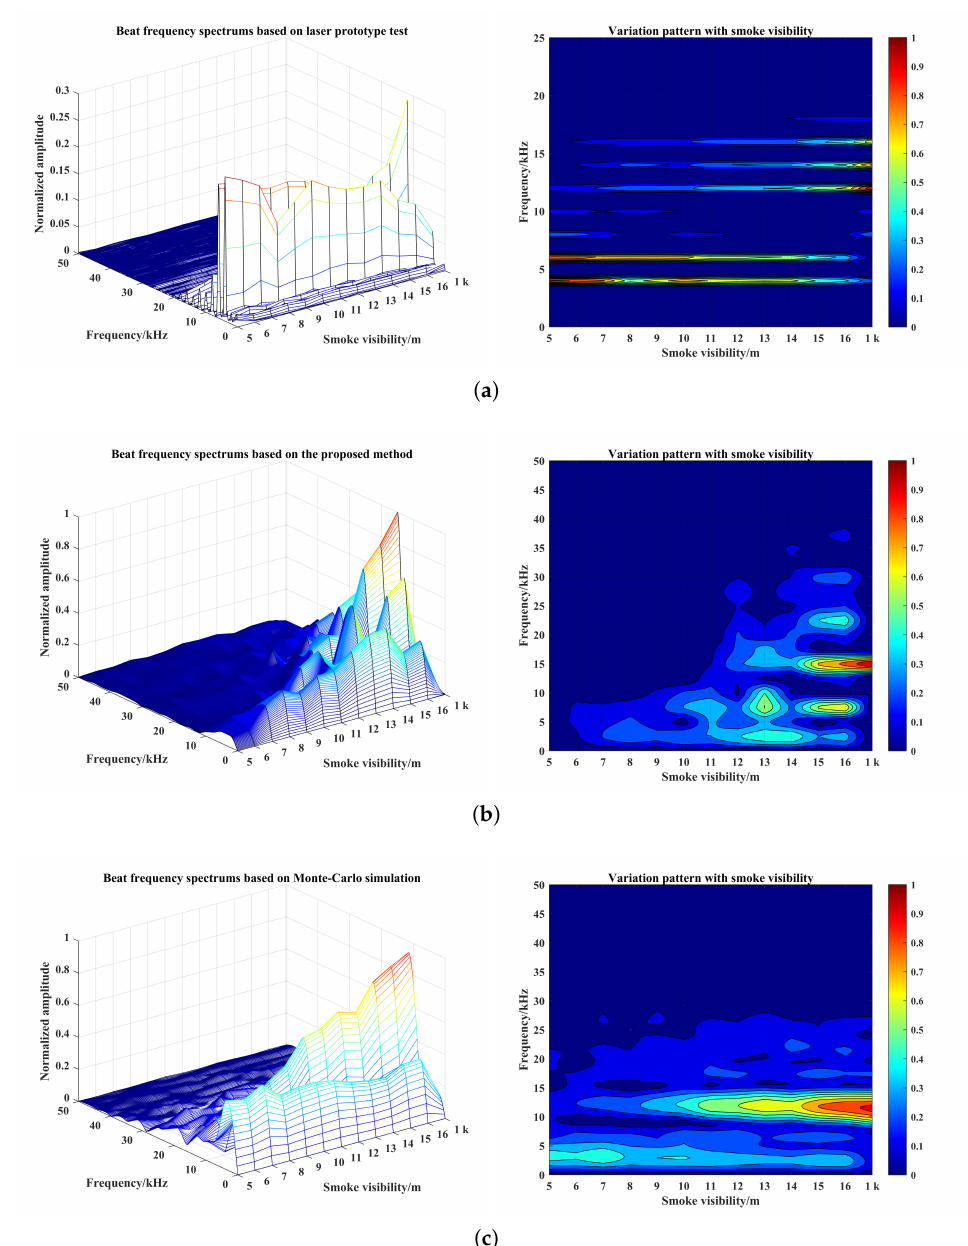
Figure 16. Results of beat signal spectrum and variation pattern with smoke visibility based on three methods: ( a ) laser prototype test, ( b ) proposed method, ( c ) Monte-Carlo